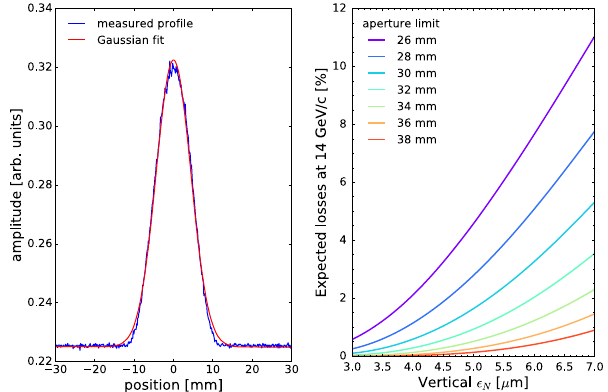
FIG. 8. Left: Wire scanner vertical profile measurement, showing the profile tails, cut by the aperture restrictions, leading to beam scraping and losses. The extent of the profile is hence a measure of the global available aperture. Right: Expected losses at the SPS flat bottom as a function of the vertical normalised emittance. The global aperture bottleneck is the internal dump, TIDVG.